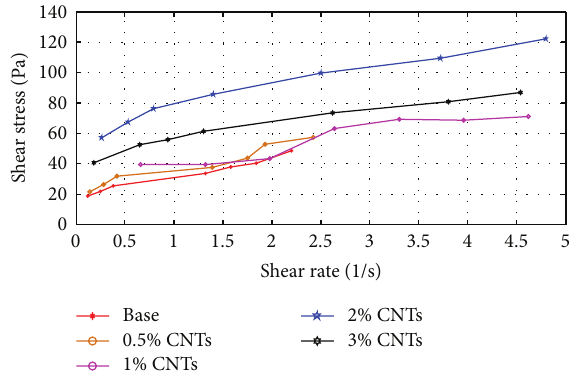
Figure 4: Shear stress of the grease samples.